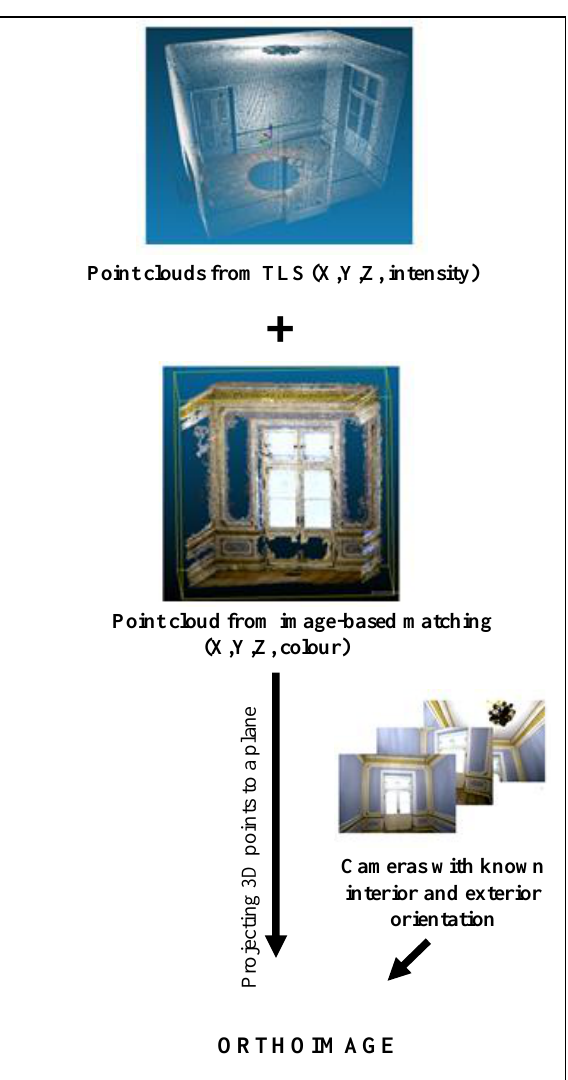
Figure 6. Diagram of integration of point clouds from terrestrial laser scanning and image matching in the generation of high-resolution orthoimages.